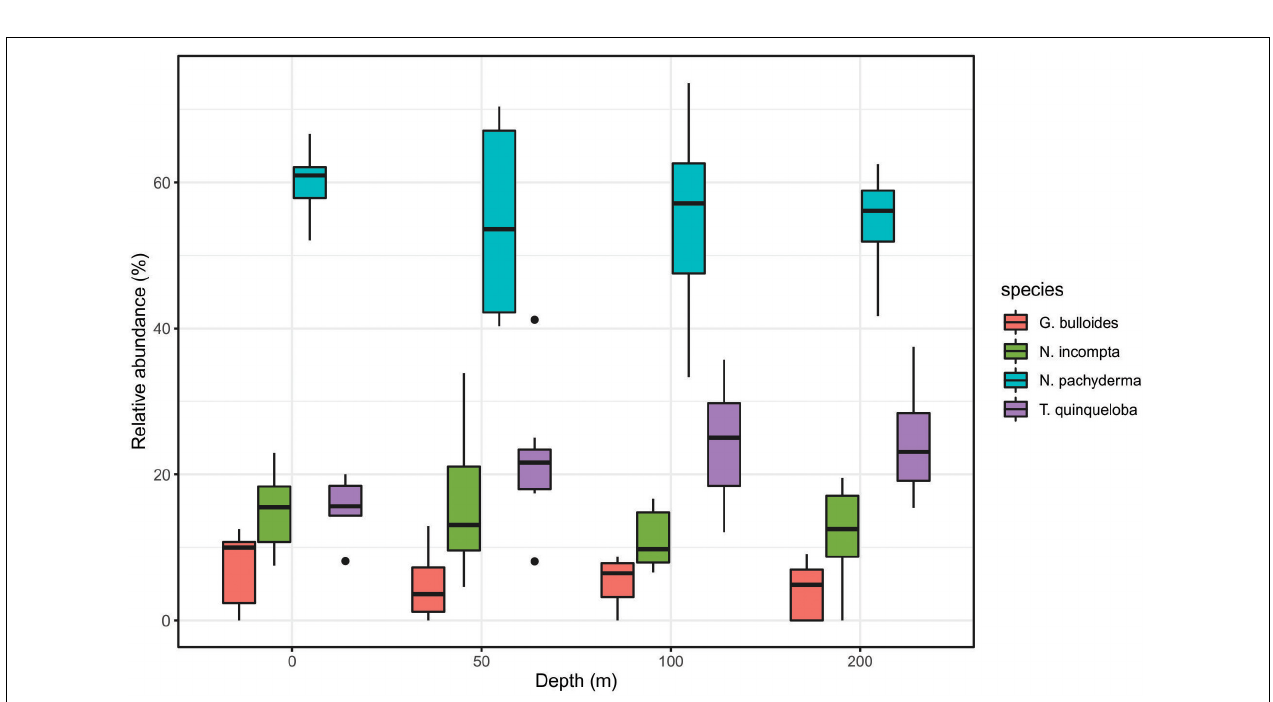
FIGURE 5 | Relative abundance (%) of planktic foraminifera (blue) and pteropods (purple) per size fraction and station. The panels represent from top to bottom: 0 to 50 m, 50 to 100 m, 100 to 200 m, and 200 to 300 m.